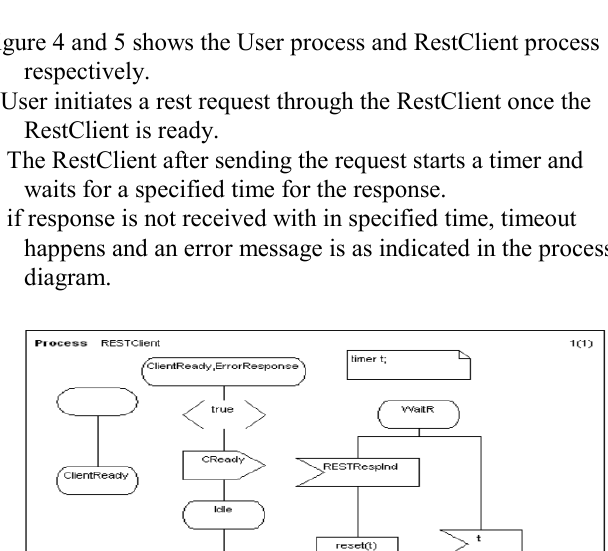
Figure 5: User Process specification